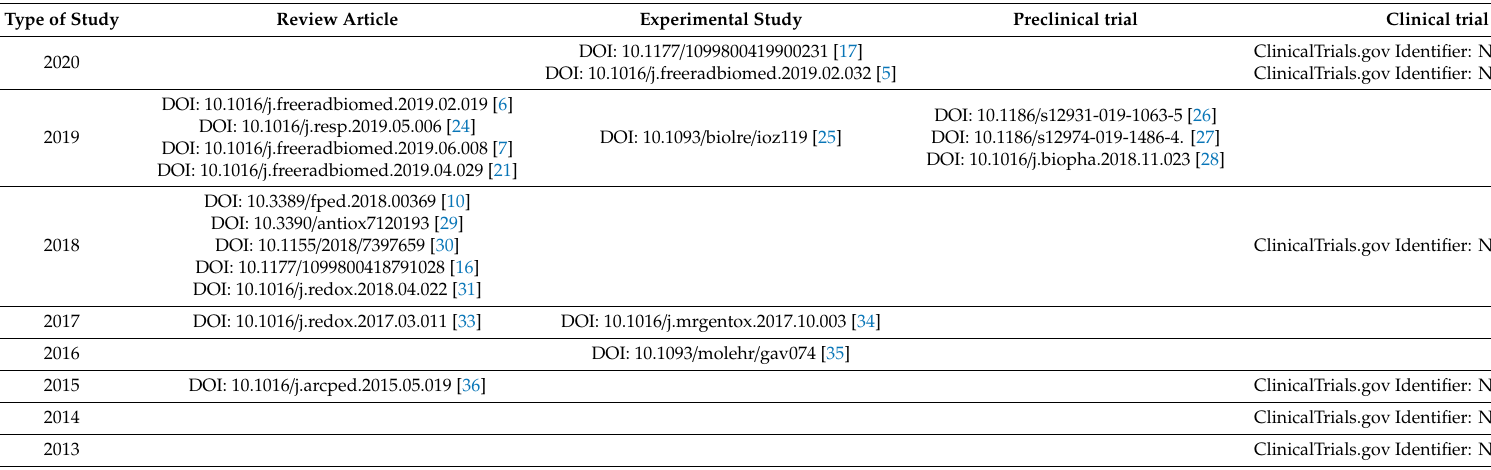
Table 1. Papers included in the